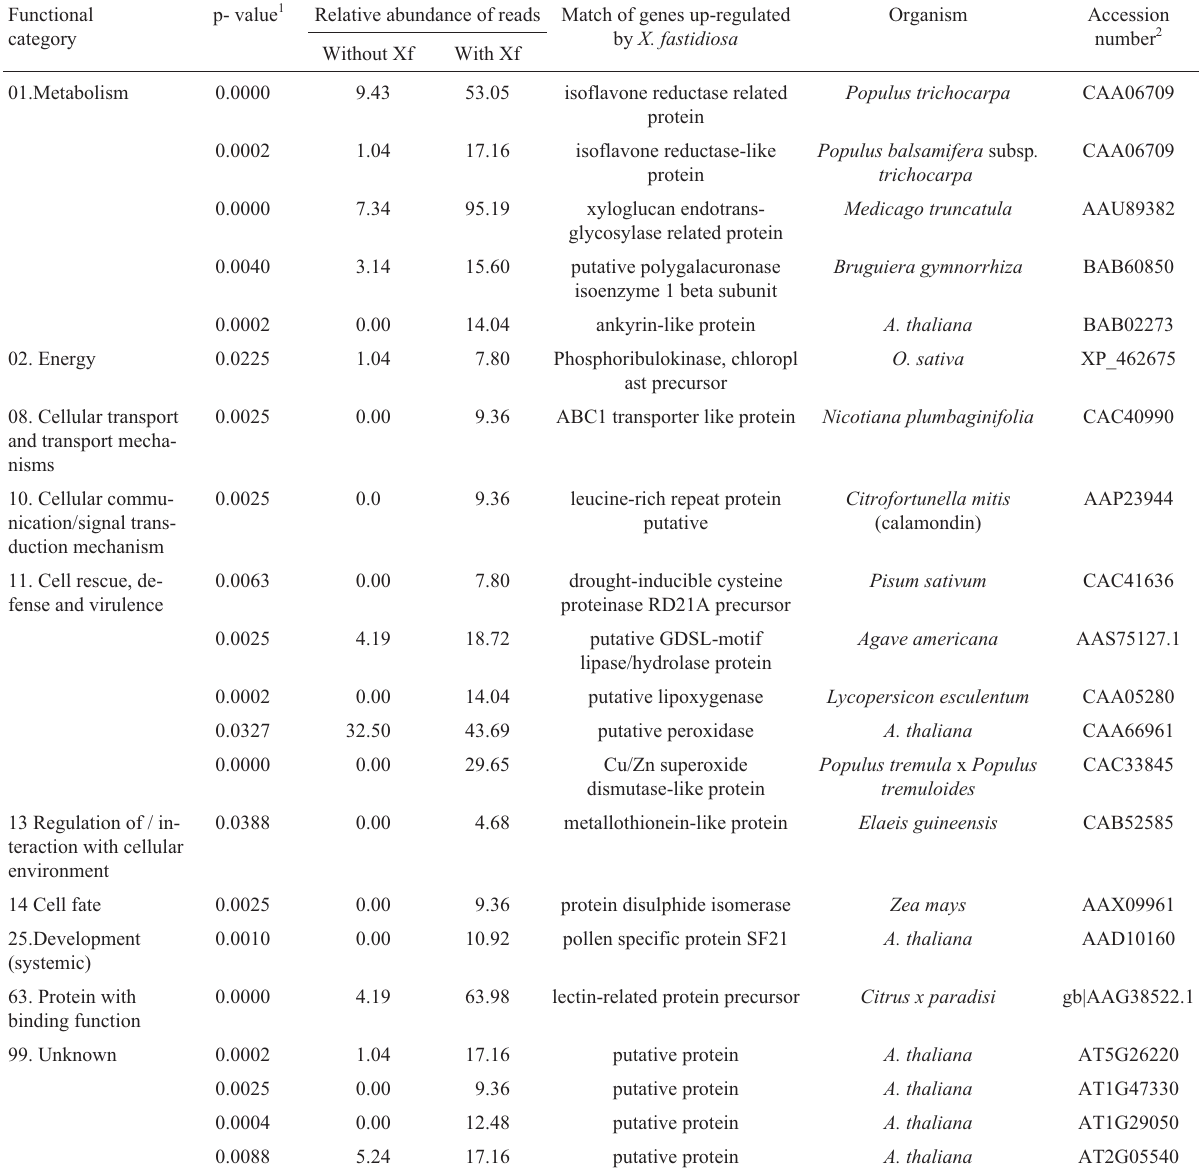
Table 2 - Functional categorization of the up-regulated genes in sweet orange plants exhibiting citrus variegated chlorosis symptoms Functional p- value 1 Relative abundance of reads Match of genes up-regulated category by X. fastidiosa